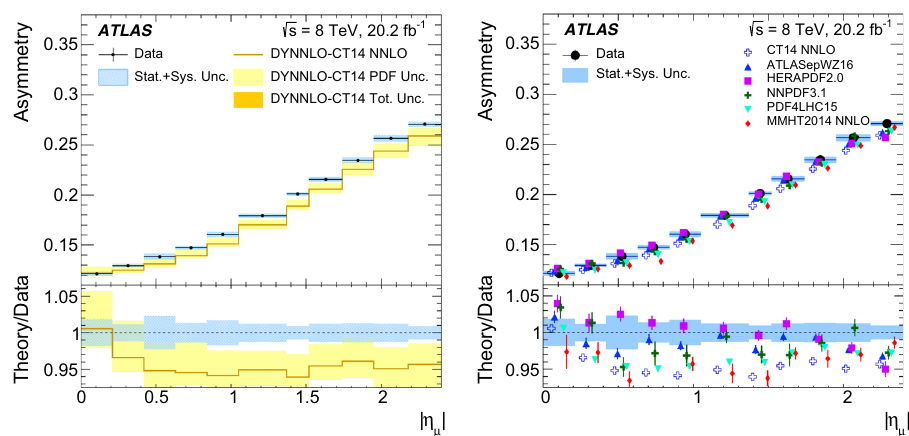
Fig. 5 The W boson charge asymmetry as a function of absolute muon pseudorapidity. The data are presented with systematic and total uncer- tainties (the data statistical uncertainties are smaller than the size of the markers). In the left plot, the data are compared with the predic- tion from DYNNLO in which the CT14 NNLO PDF set is used. The DYNNLO prediction is also shown with its associated total theoretical